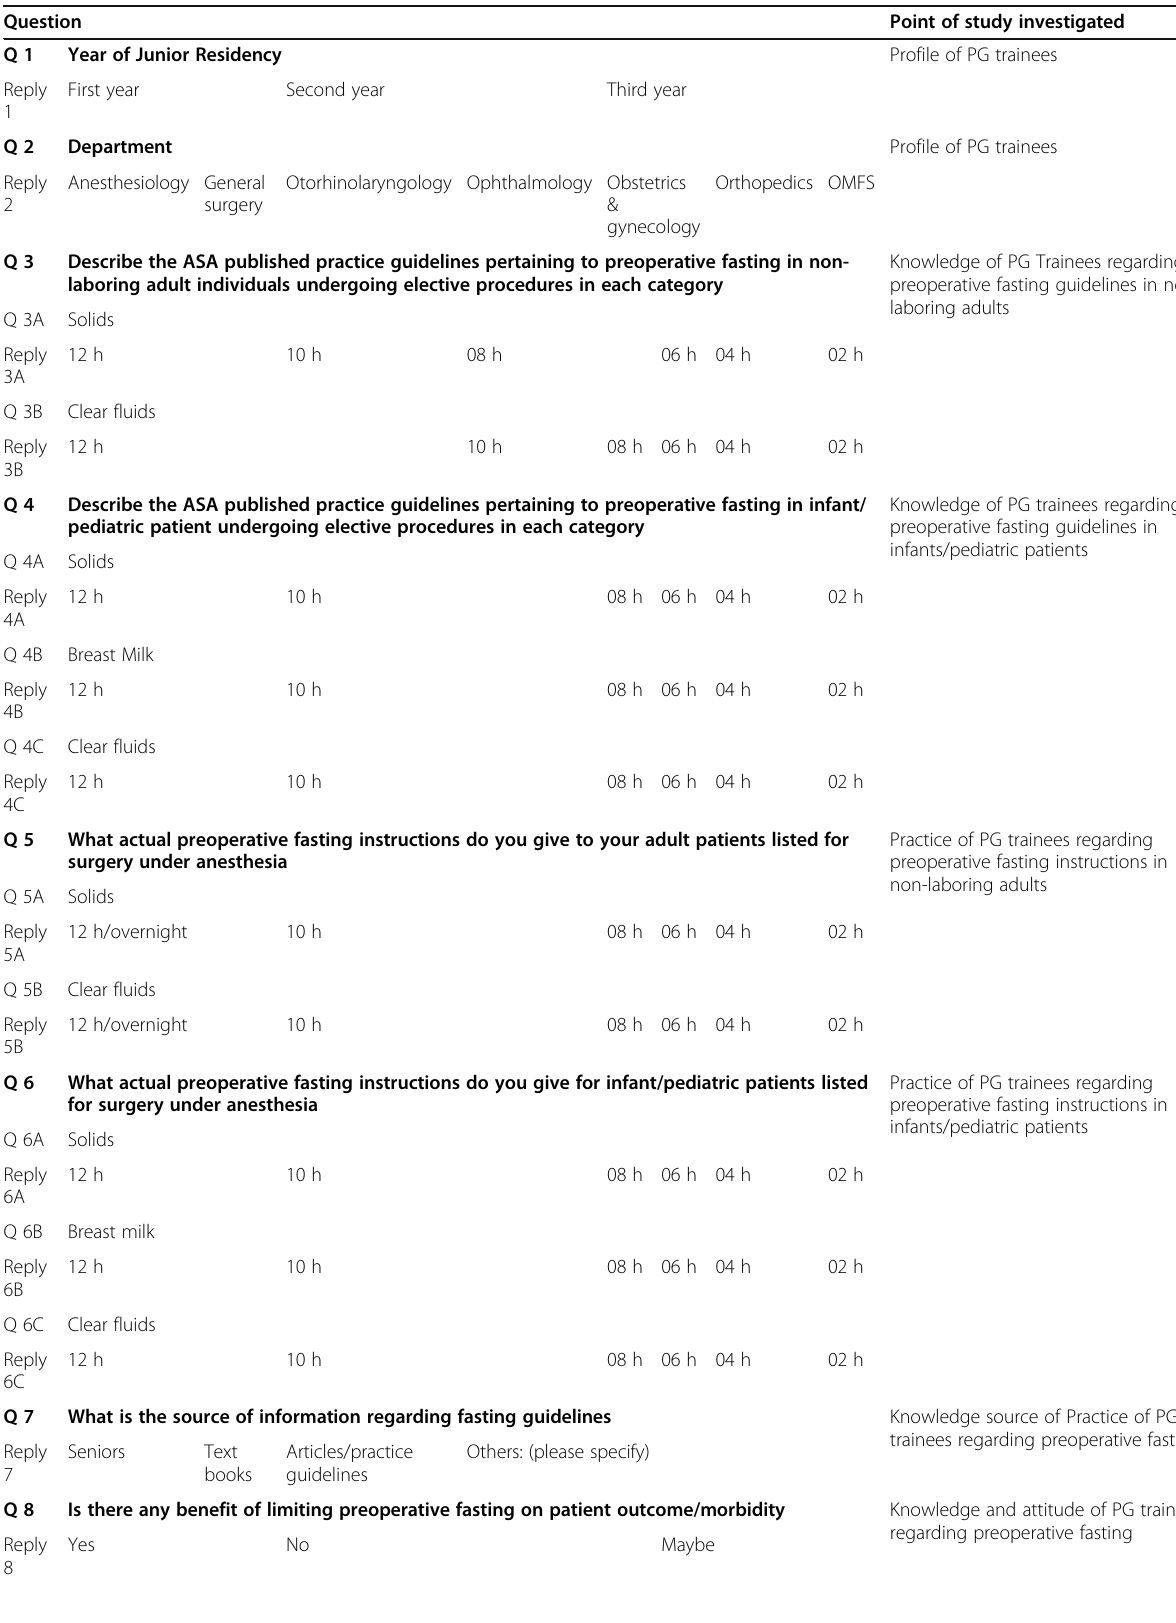
Table 1 Questionnaire with list of